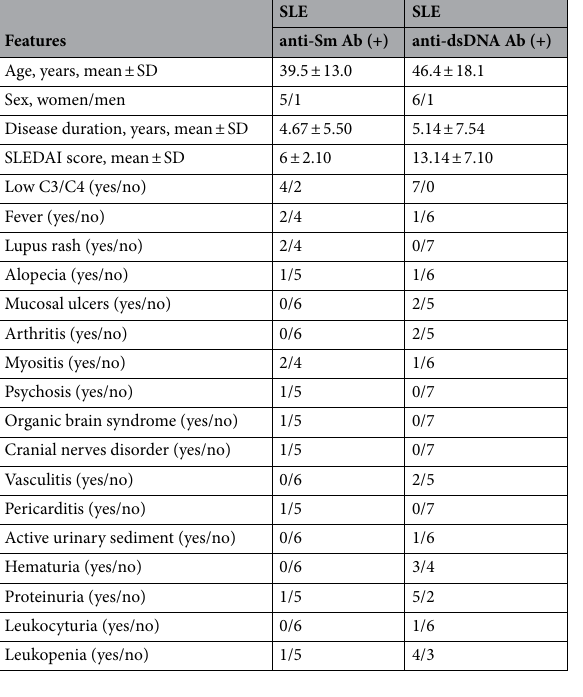
Table 2. SLE patient clinical characteristics. anti-Sm Ab anti-Smith antibodies, anti-dsDNA anti-double- stranded DNA antibodies, SLEDAI Systemic Lupus Erythematosus Disease Activity